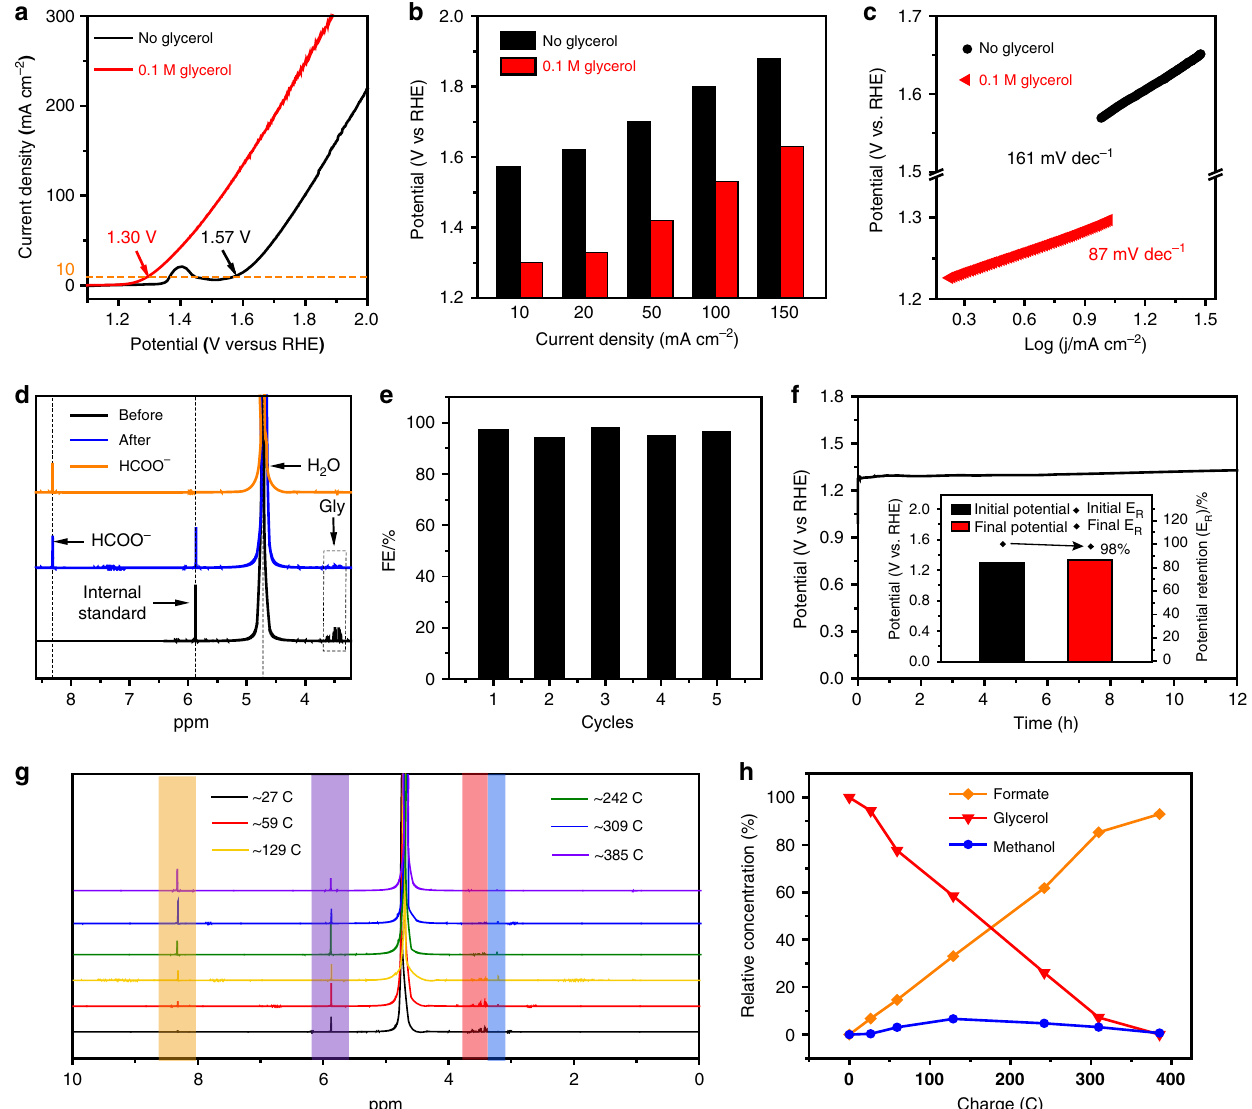
Fig. 2 Electrocatalytic performances of Ni – Mo – N/CFC in glycerol oxidation at the anode. a LSV curves of Ni – Mo – N/CFC anode in 1.0 M KOH with and without 0.1 M glycerol (Gly) addition. Scan rate, 2 mV s − 1 . b Comparisons of the anodic potentials to achieve varied current densities for Ni – Mo – N/CFC in 1 M KOH with and without 0.1 M glycerol addition. c Tafel plots for the anodic glycerol oxidation or OER derived from ( a ). d 1 H NMR spectra of products before and after 12 h anodic glycerol oxidation on Ni – Mo – N/CFC electrode by using Maleic acid as the internal standard, and that of standard formate, demonstrating the conversion of most glycerol to formate. e Faradaic ef fi ciencies (FEs) of Ni – Mo – N/CFC for formate production for fi ve successive electrolysis cycles. f Twelve hour stability test of Ni – Mo – N/CFC for the anodic glycerol oxidation at a current density of 10 mA cm − 2 . The inset image in f shows the changes of the potentials during chronopotentiometric glycerol oxidation tests (bar graphs). g 1 H NMR measurements of glycerol oxidation of glycerol (red) to formate (orange) and methanol (blue). Maleic acid was added as an internal standard (purple). h Glycerol consumption into formate and